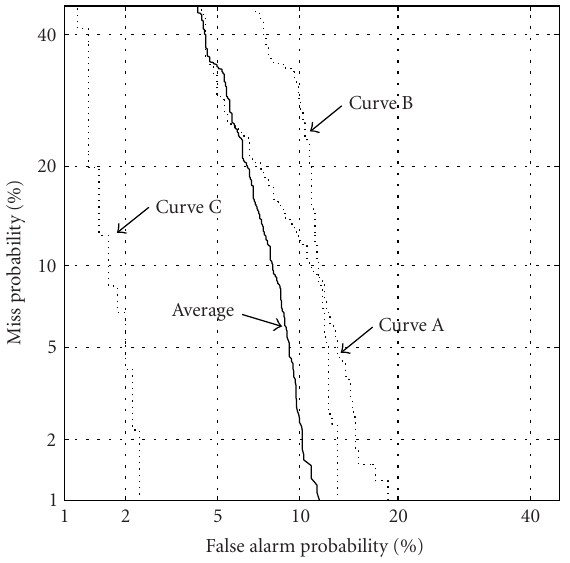
Figure 9: DET curves of three speakers and their